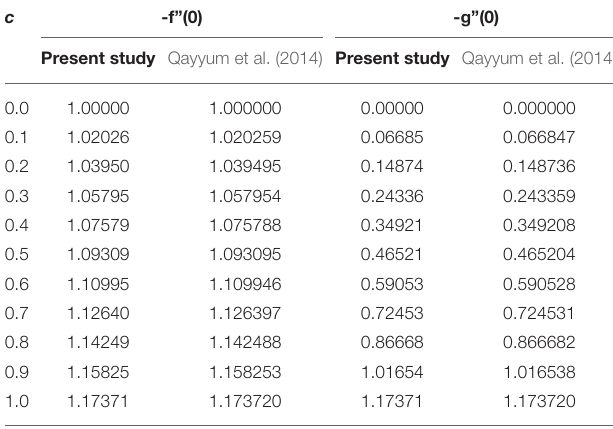
f ′′ (0) and g ′′ (0) for different values of c with − − (Qayyum et al.,